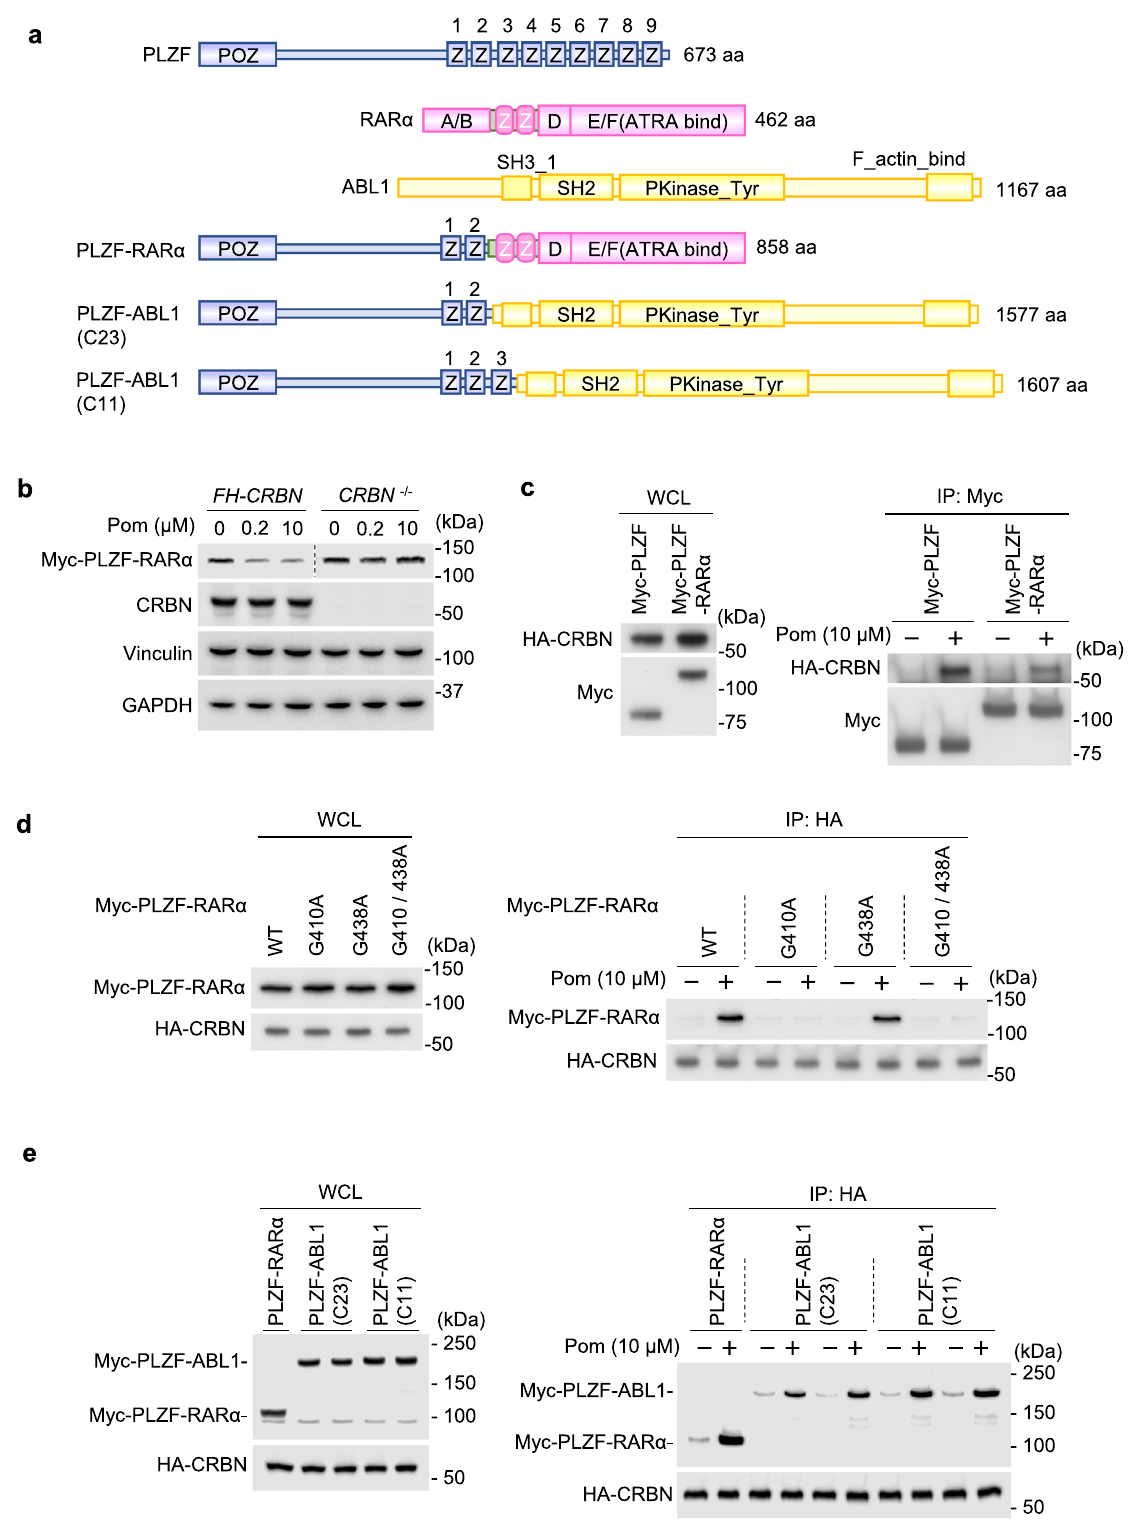
Fig. 4 PLZF fusion proteins are neosubstrates of CRL4 CRBN . a Schematic representation of PLZF, RAR α , ABL1, and three PLZF fusion proteins. b Myc tagged-PLZF-RAR α was overexpressed in 293T expressing FLAG-HA (FH)-CRBN and 293T lacking CRBN , treated with DMSO or pomalidomide, and subjected to immunoblot analysis. c FH-CRBN and Myc-FLAG (MF)-PLZF or Myc-PLZF-RAR α were coexpressed in 293T cells and immunoprecipitated with anti-Myc antibody in the presence or absence of pomalidomide. d FH-CRBN and Myc-PLZF-RAR α carrying point mutations were coexpressed in 293T cells and immunoprecipitated with anti-HA antibody in the presence or absence of pomalidomide. e FH-CRBN and Myc-PLZF-ABL1 were coexpressed and immunoprecipitated in the presence or absence of pomalidomide. WCL whole-cell lysate. All experiments were conducted more than twice with similar